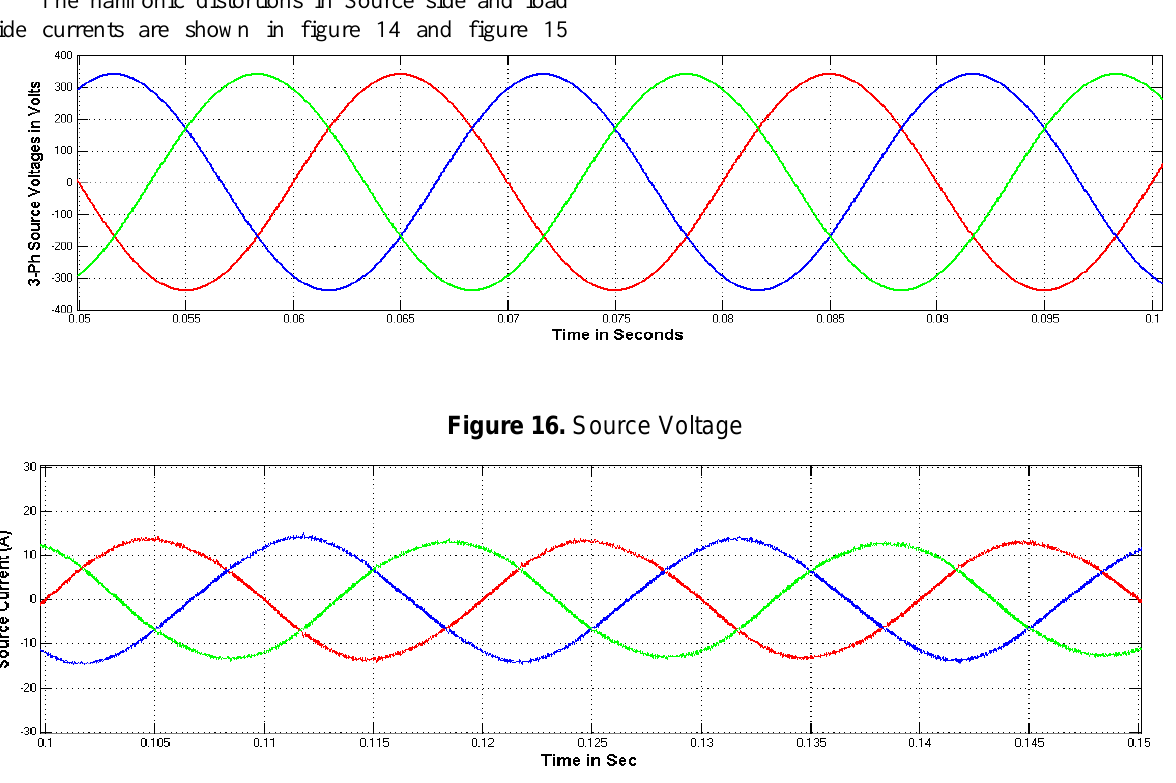
Figure 17. Three-phase source